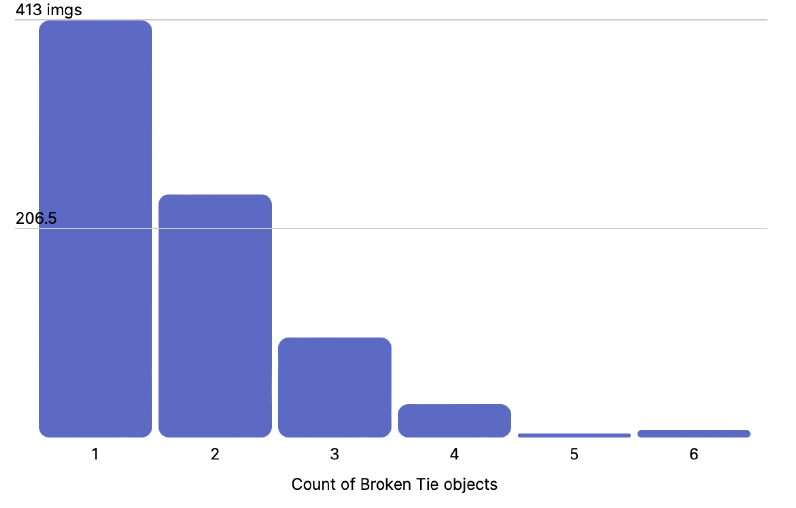
Figure 15. Distribution of broken tie objects per